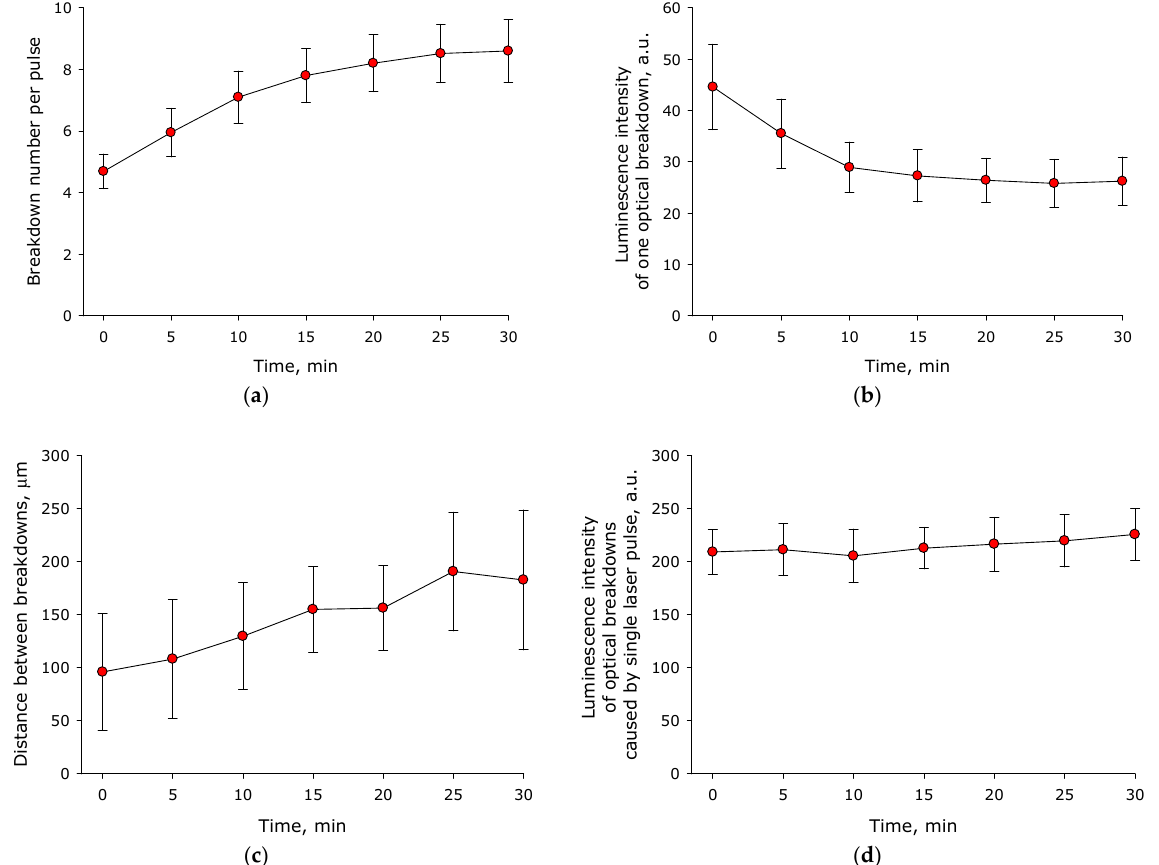
Figure 2. Influence of laser irradiation time of aqueous solution of BSA (1 mg/mL) on the charac- teristics of optical breakdown plasma ( n = 3, Mean ± SEM). ( a ) Influence of the time of irradiation of an aqueous solution of BSA with laser on the number of optical breakdowns caused by a single laser pulse. ( b ) Effect of laser irradiation time of aqueous BSA solution on the average luminescence intensity of individual optical breakdown. ( c ) Influence of the time of irradiation of aqueous solution of BSA with laser on the average distance between optical breakdowns caused by a single laser pulse. ( d ) Effect of laser irradiation time of aqueous BSA solution on the average lumines- cence intensity of optical breakdowns induced by a single laser pulse.